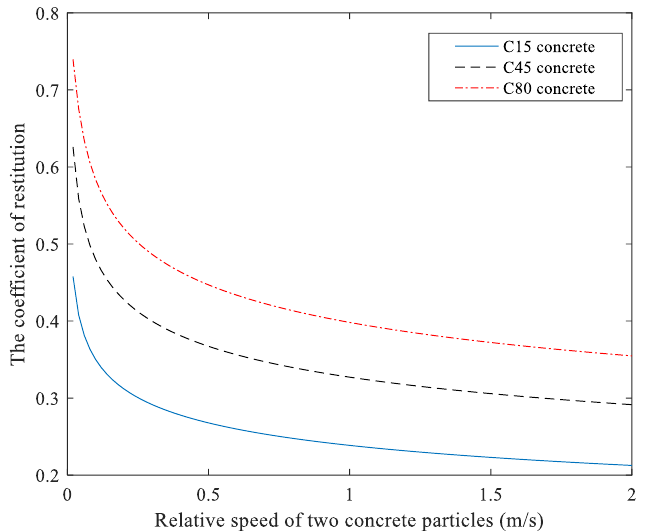
Figure 2. The relation between particles speed and restitution coefficients with the chosen concretes.